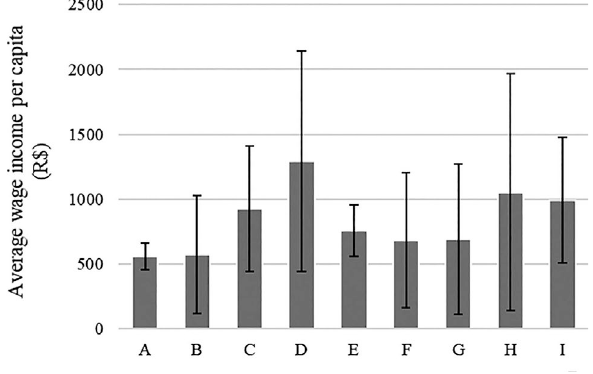
Figure 3 - Average wage income per capita and its respective standard deviations relative to the surroundings of each public swimming pool in the municipality of Limeira, SP. Source: